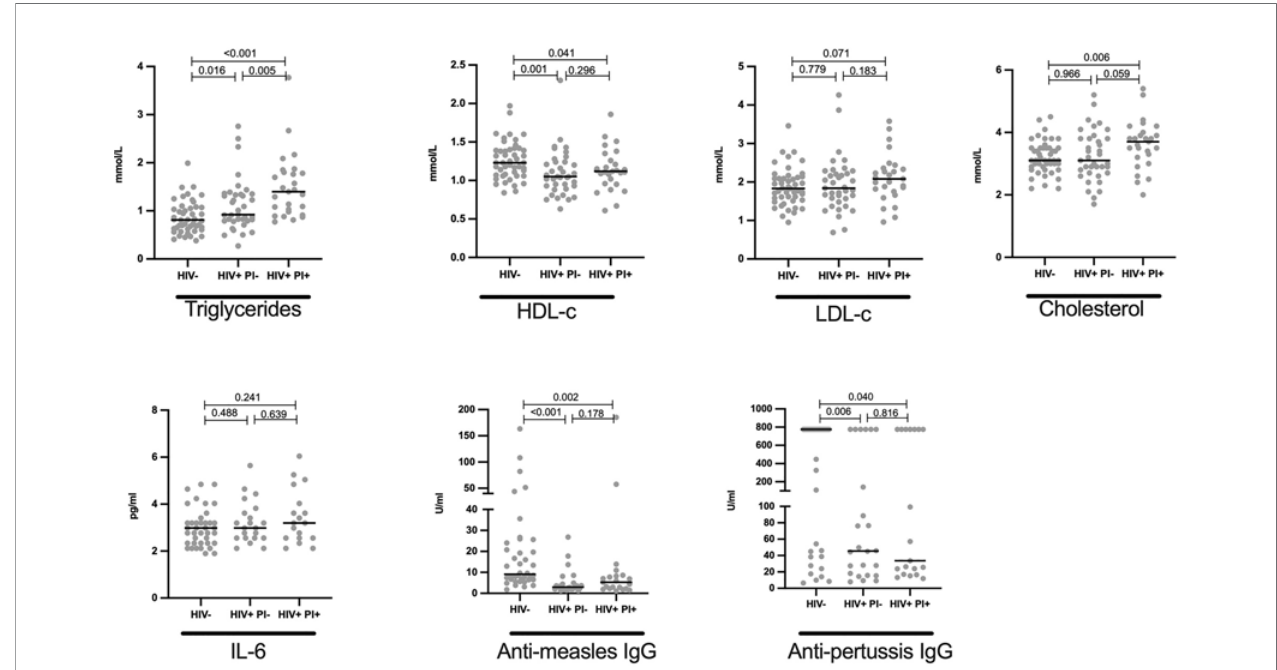
FIGURE 4 | Elevated levels of cholesterol and triglycerides in HIV+ children on protease inhibitor ART: Plasma quantity for triglycerides, HDL, LDL, cholesterol in mmol/L; IL-6 in pg/ml, anti-measles IgG and anti-pertussis in U/ml are shown and strati fi ed by HIV status. Each dot represents an individual volunteer, the median is indicated Statistical analysis was performed using the Mann-Whitney